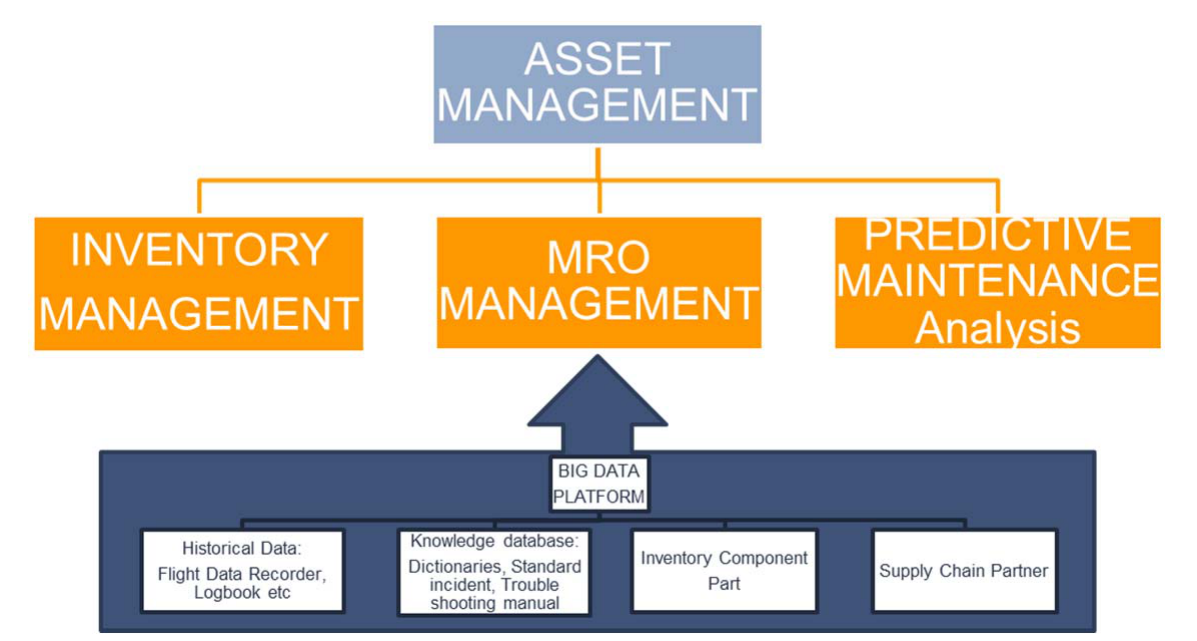
Figure 1. Diagram Military Asset